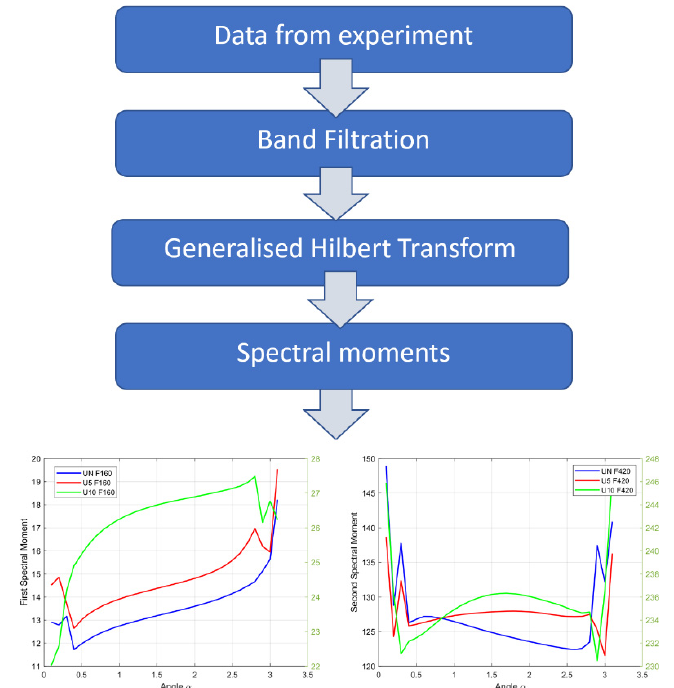
Figure 9. Diagram of the method for fault-detection.